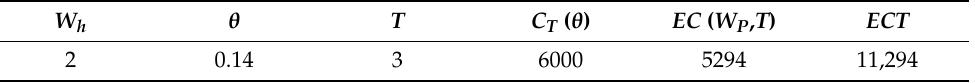
Table 2. The optimal disease-monitoring strategy and treatment decision for warranty period W h .